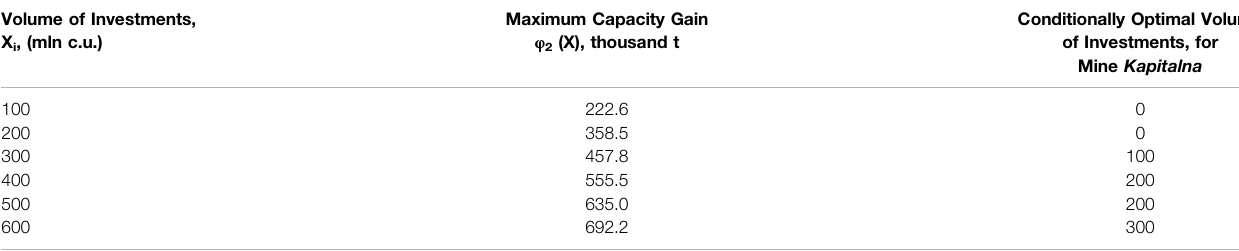
TABLE 5 | Conditionally optimal volume of investments, for mine Kapitalna . Volume of Investments, X i , (mln